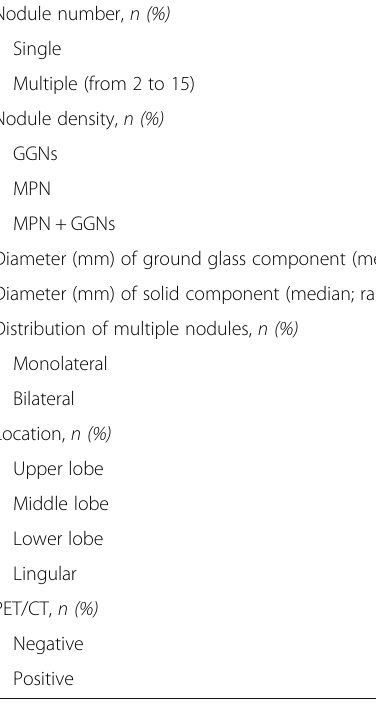
Table 2 Characteristics of pulmonary nodules (patient-based